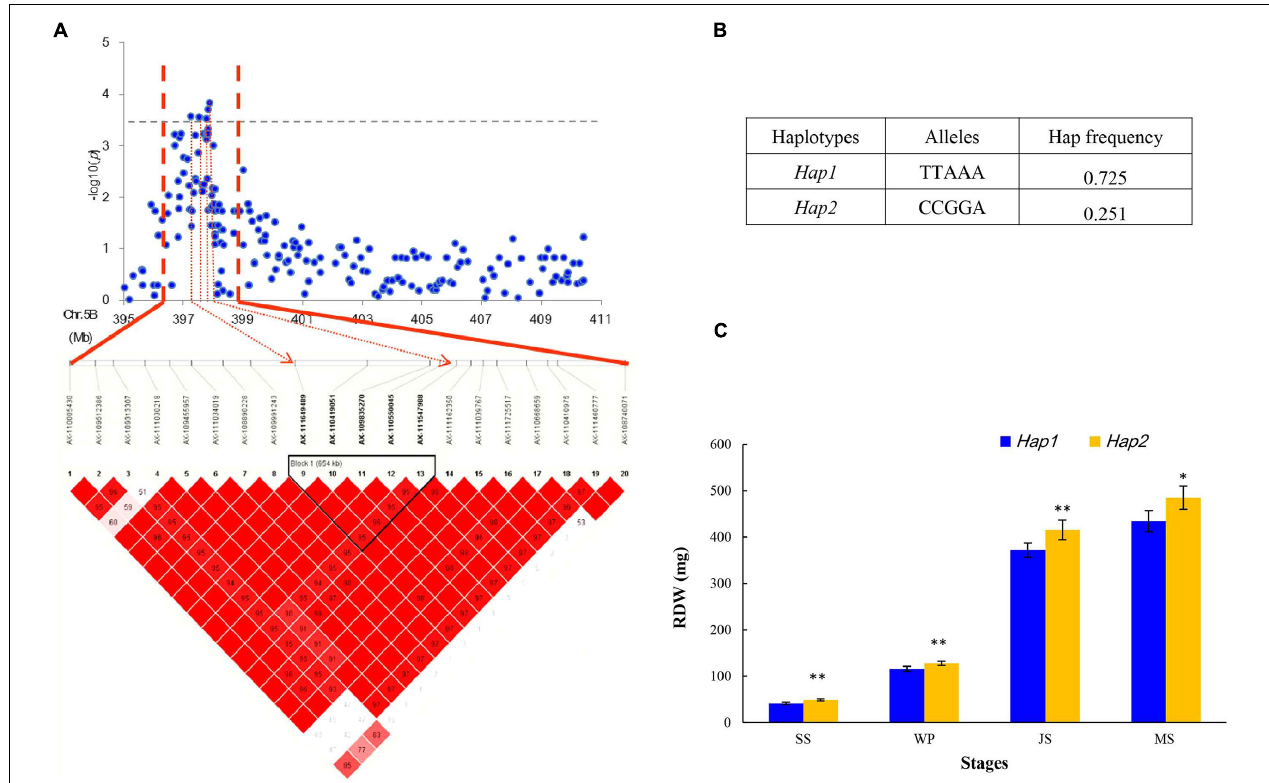
FIGURE 4 | Haplotype analysis of SNPs in the stable region at 397.72–410.88 Mb on chromosome 5B. (A) Local Manhattan plot (top) and LD heatmap (bottom) surrounding the peak on chromosome 5B; (B) two haplotypes with different alleles; and (C) phenotypic effects of different